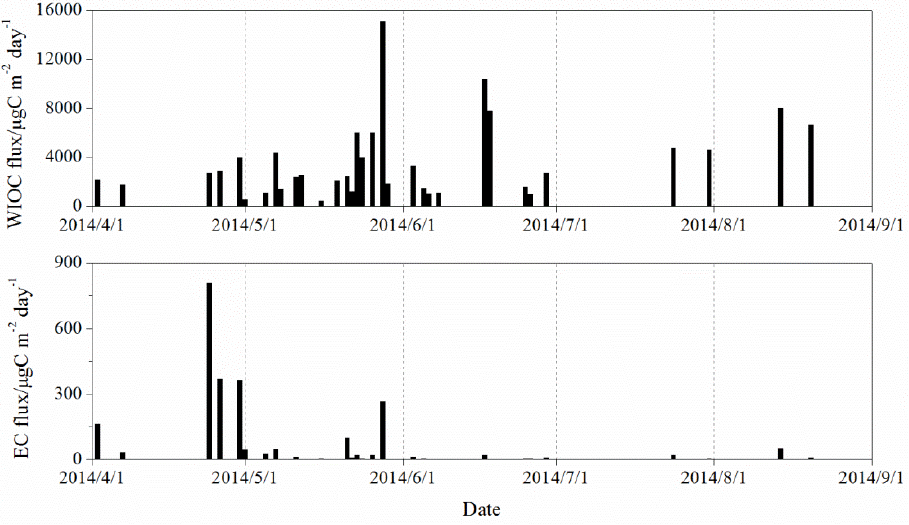
Figure 6. EC and WIOC daily wet deposition flux at Xiamen during the sampling period.